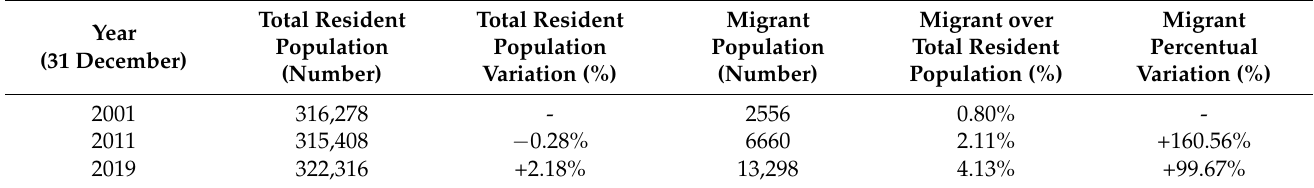
Table 1. Population data of Bari. Source: